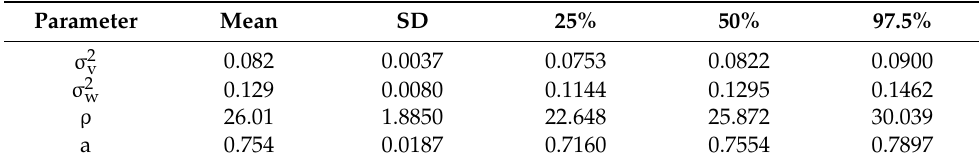
Table 3. Posterior estimates (mean, standard deviation, and